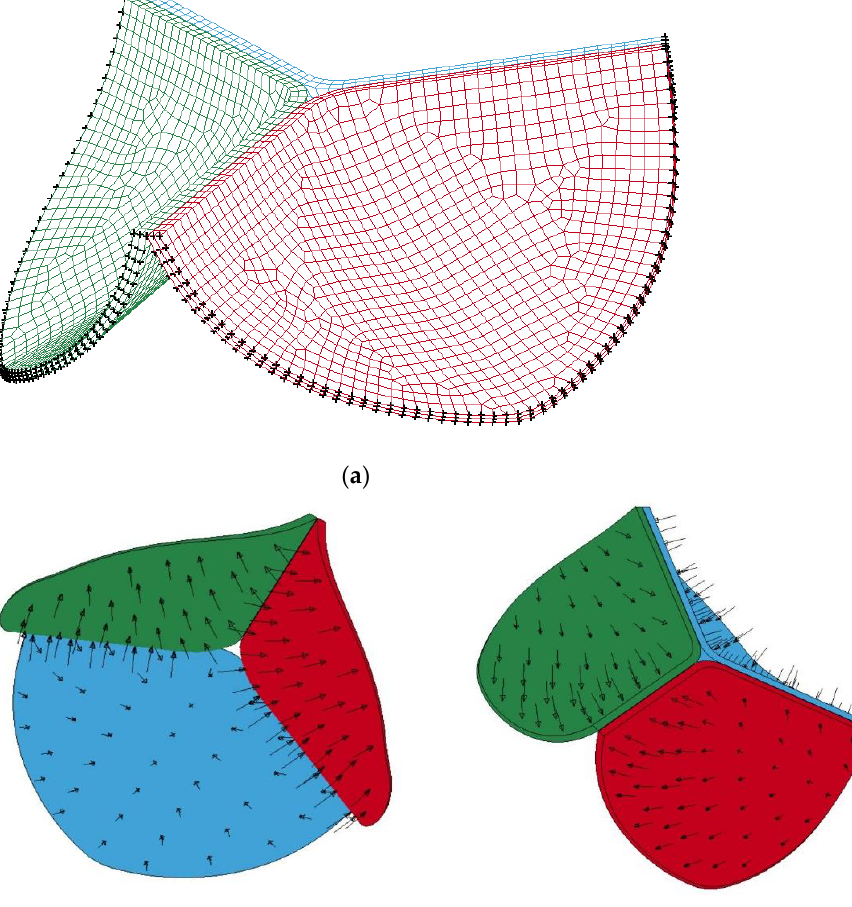
Figure 4. Geometrical and mechanical boundary conditions. ( a ) Geometric boundary condition, and ( b ) Mechanical boundary conditions (left: inner layer, right: outer layer).